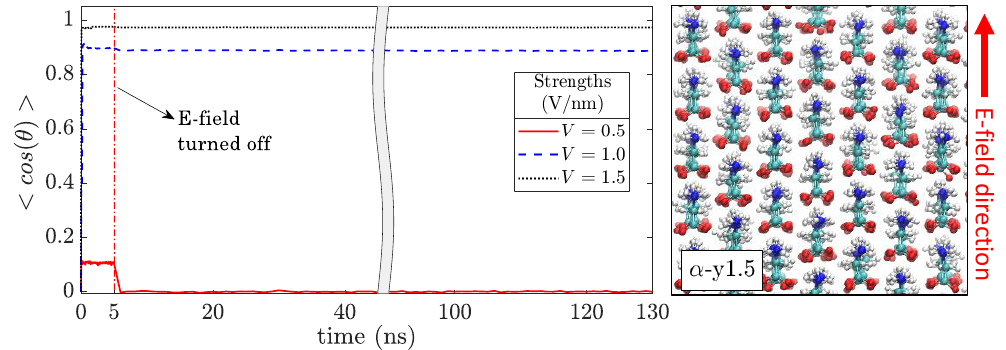
Figure 6. ( Left ) Alignment of the molecules in an initially α -glycine crystal. An electric field with a strength of 0.5 V/nm (red), 1.0 V/nm (black), and 1.5 V/nm (blue) was applied for 5 ns and then turned off. The simulation was carried on for an additional 125 ns. ( Right ) Snapshot of the new polymorph obtained 125 ns after the e-field (in y-direction, V = 1.5 V/nm) had been turned